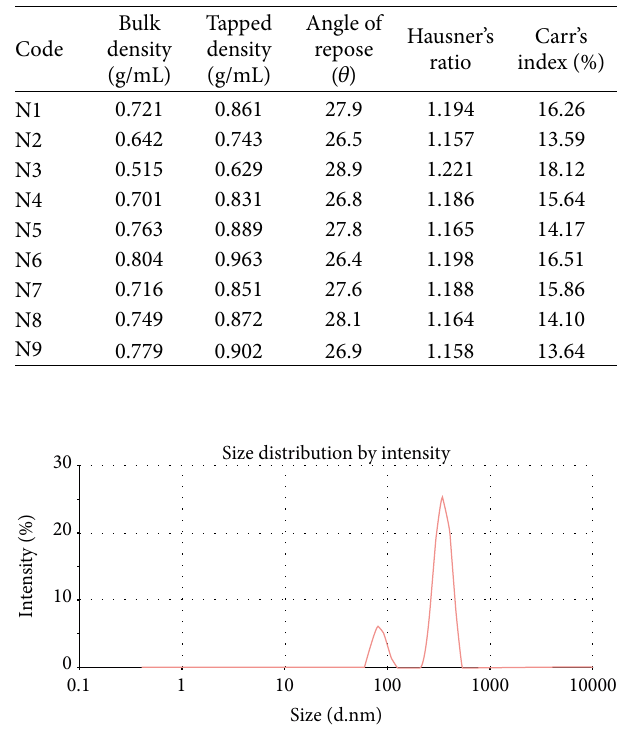
Figure 3: Average particles size of